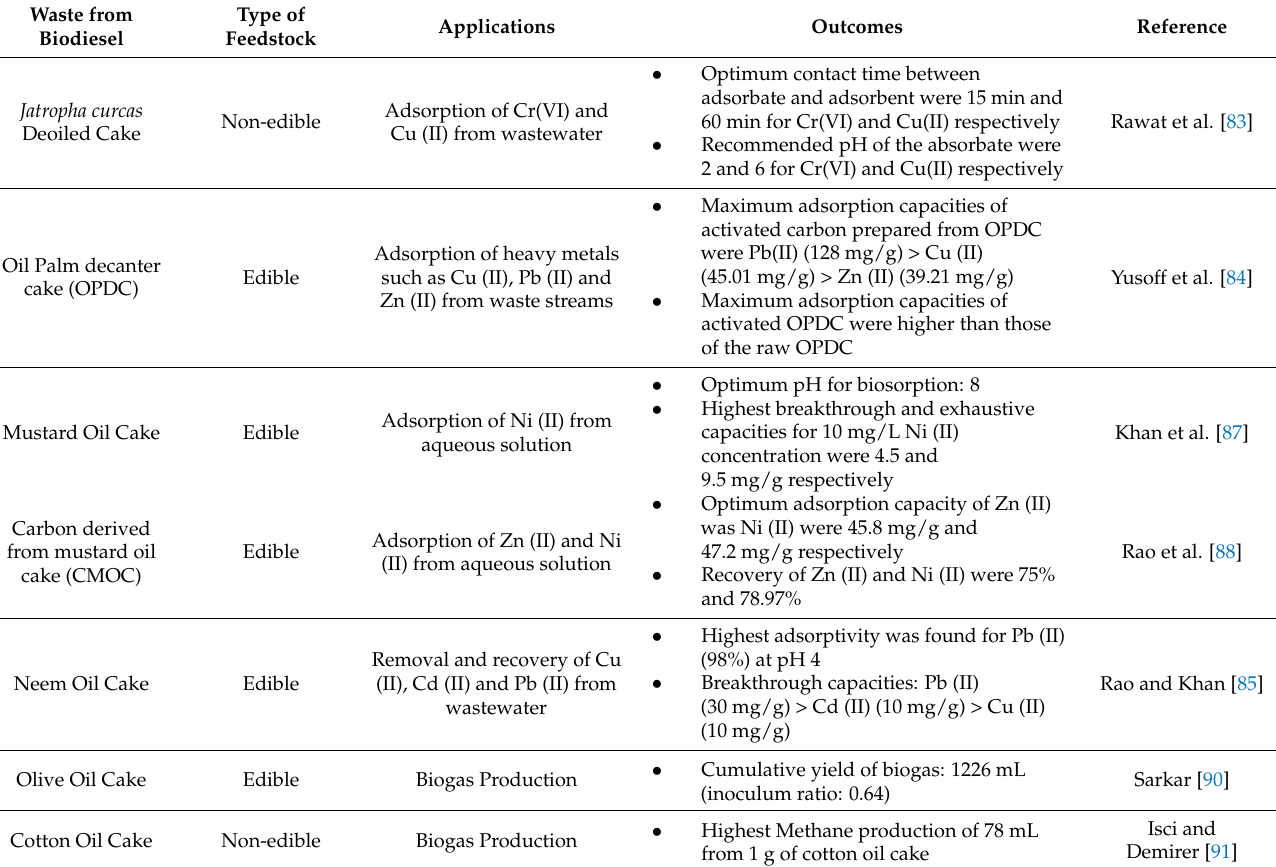
Table 2. Different applications of biodiesel waste through